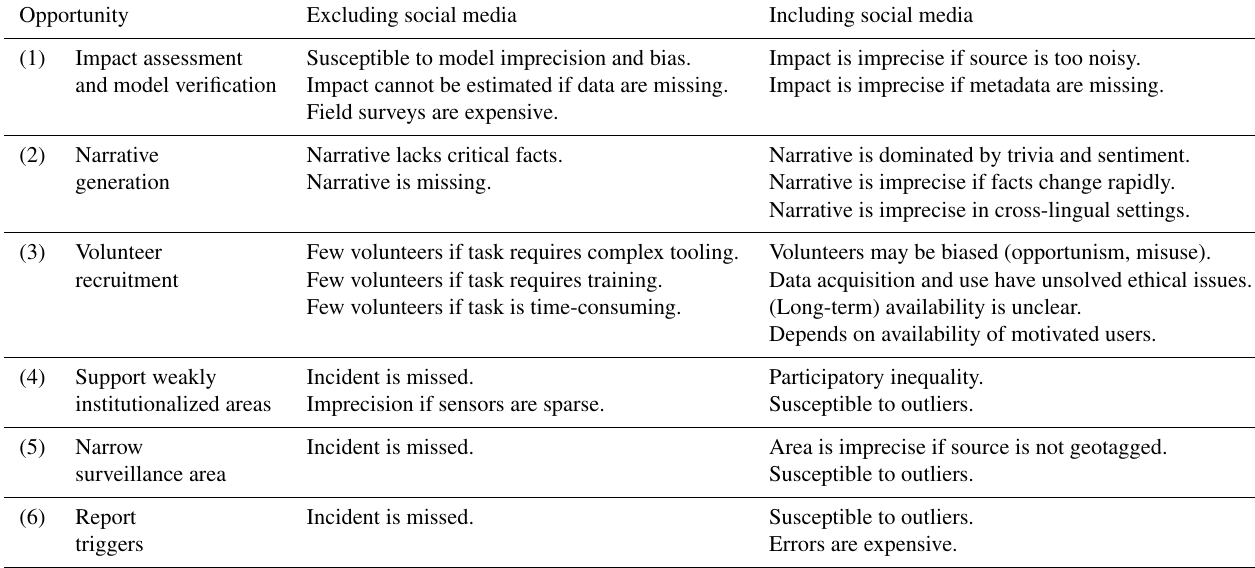
Table 4. Overview of the trade-off when using social media data to gather incident information by application scenario. The risks of excluding social media as an information source are due to lower recall, and those of including social media means are due to lower